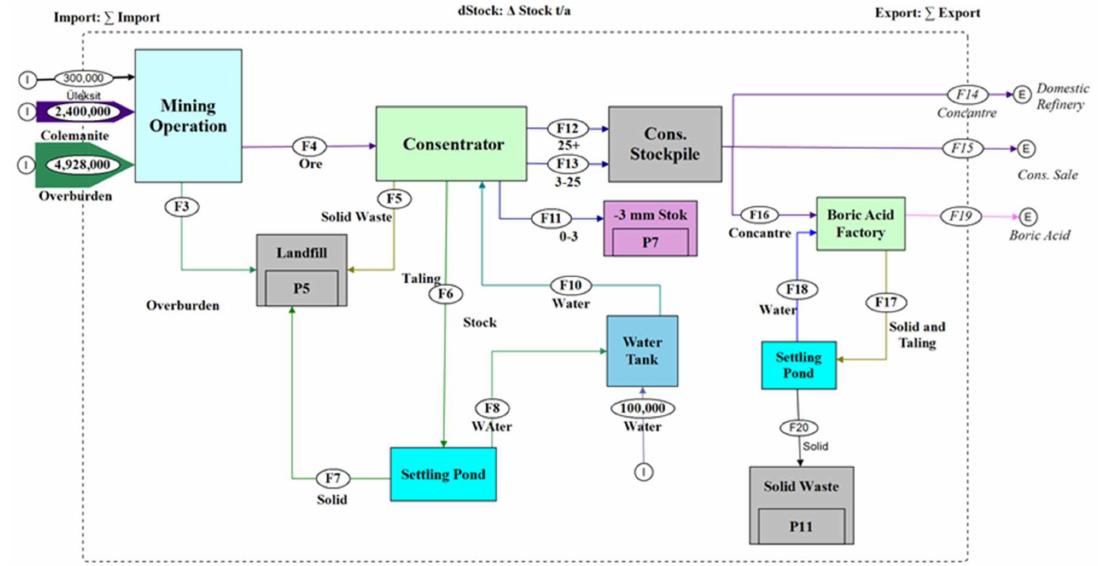
Figure 9. MFA modes of colemanite and the processes and